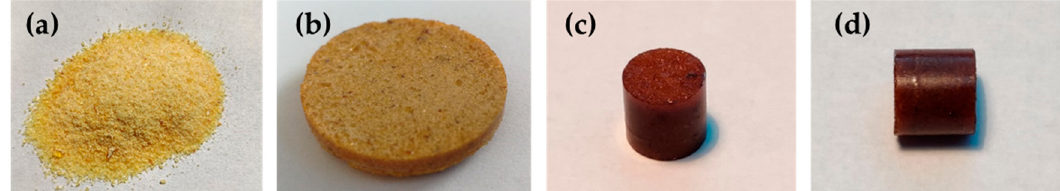
Figure 6. ( a ) Grinded powder from 3-DGOA-0.5-Zn networks. ( b ) Remolded test specimen obtained by applying 5 bar at 220 °C. The diameter of the disc is 25 mm. ( c , d ) Remolded test specimen obtained by applying 500 bar at 250 °C. The diameter of the cylinder is 7 mm.